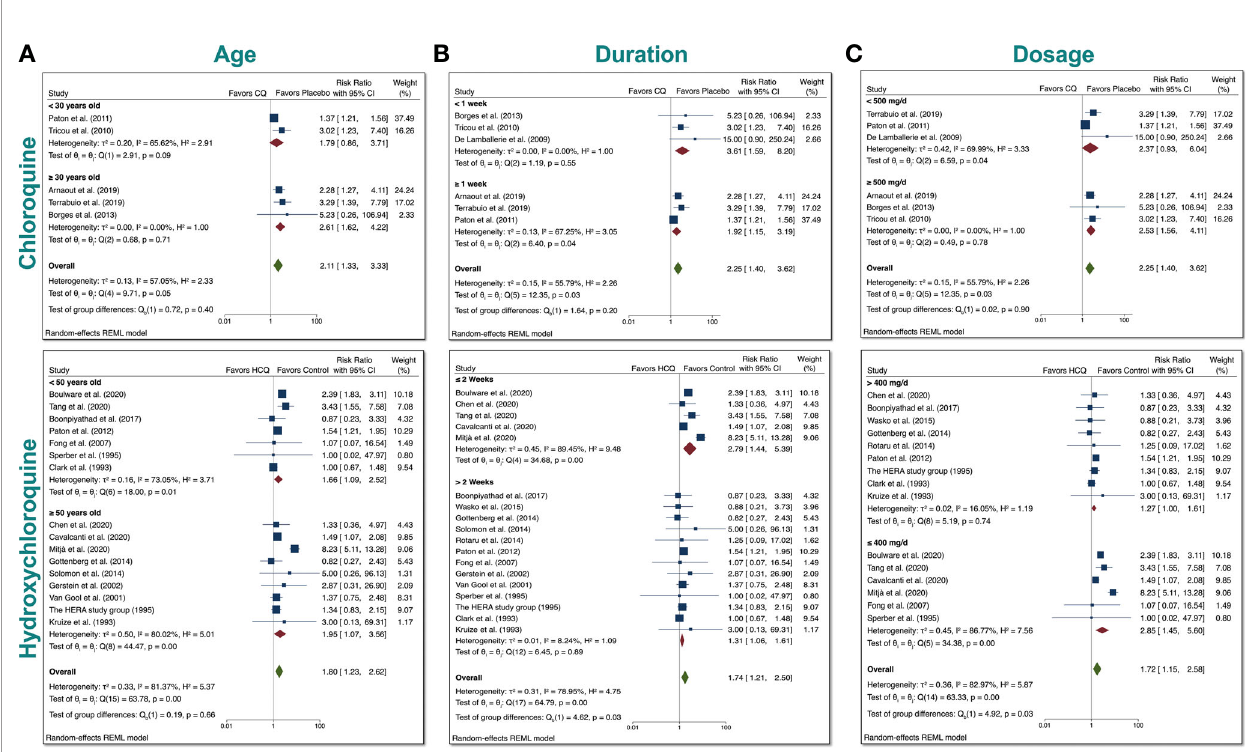
FIGURE 6 | Subgroup meta-analyses for CQ and HCQ with respect to age, duration, dosage. We strati fi ed the dosages used in the studies for both CQ and HCQ into two subgroups. We then performed subgroup analysis for dosage and trial duration. (A) For age, we separated CQ trials into <30 years old and ≥ 30 years old, while we separated HCQ trials into <50 years old and ≥ 50 years old. (B) For drug duration, we divided CQ studies into <1 week and ≥ 1 week, while we divided HCQ studies into <6 months and ≥ 6 months. (C) And for dosage, we wanted to investigate if there was a difference in using <500 mg/day versus using ≥ 500 mg/ day for CQ, and ≥ 400 mg/day versus <400 mg/day for HCQ. Statistical data are presented in the fi